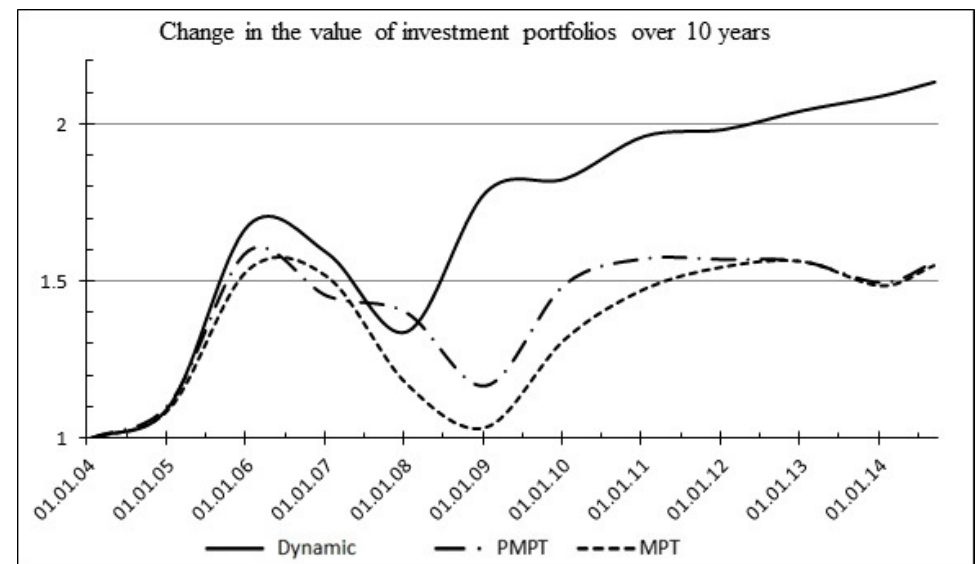
Figure 15. Simulation modeling